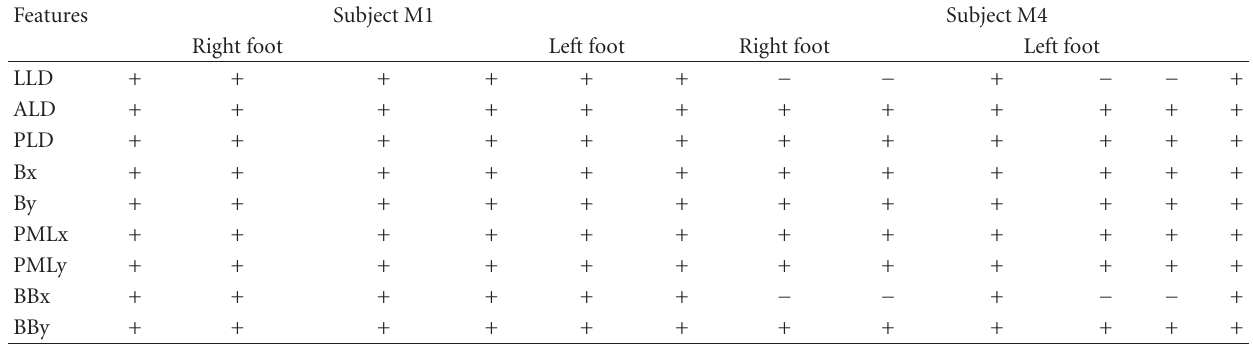
Table 3: Student’s t -test analysis of the features in male subjects M1 and M4 during 3 sessions with the 2D guide ( P > . 000125 → “+,” P < . 000125 → “ − ”).